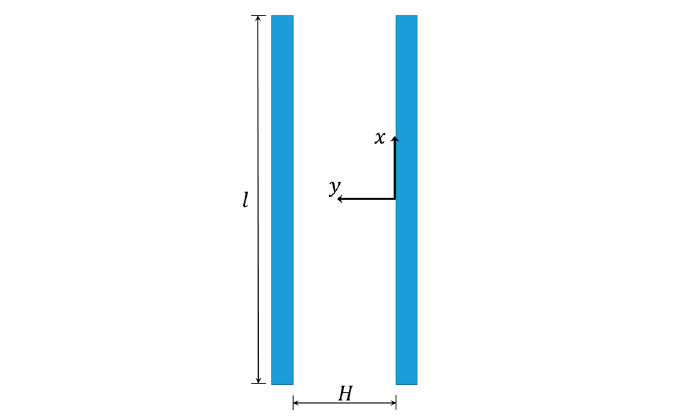
Figure 2. Lateral view of the parallel plates and of the considered fluid film in between: notation.